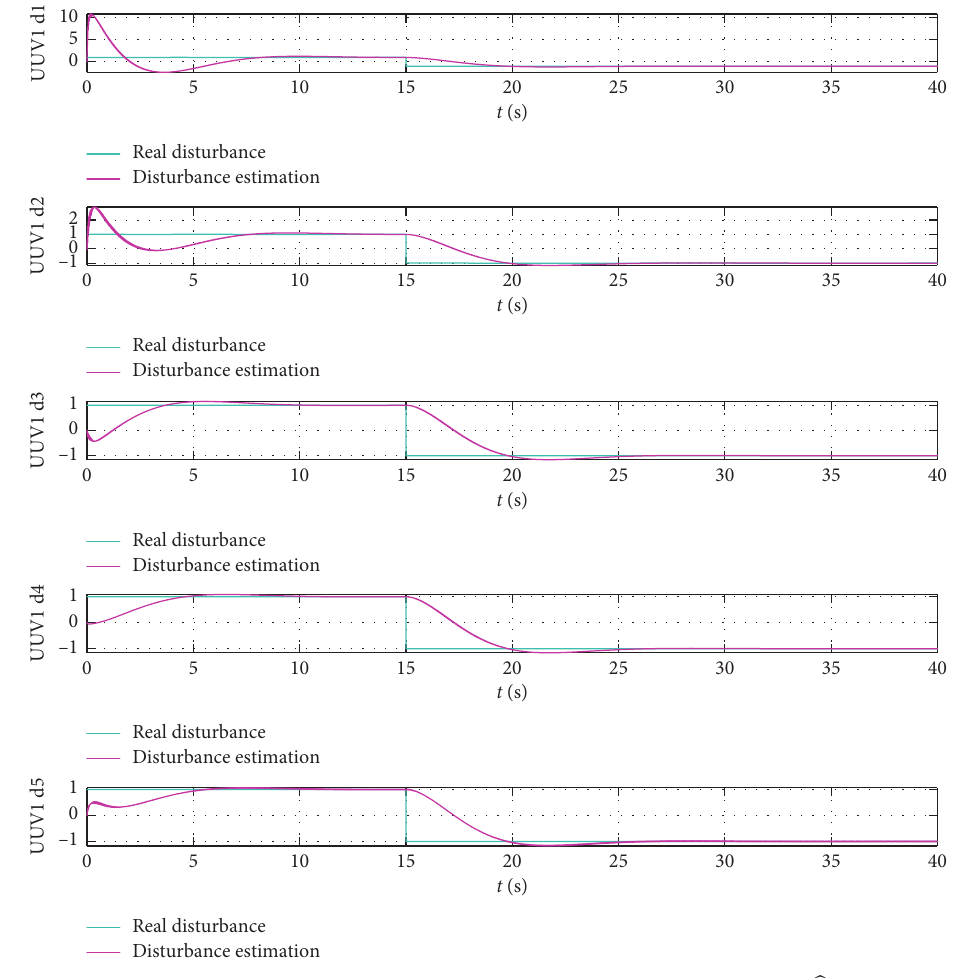
and disturbance estimation 􏽢 d 1